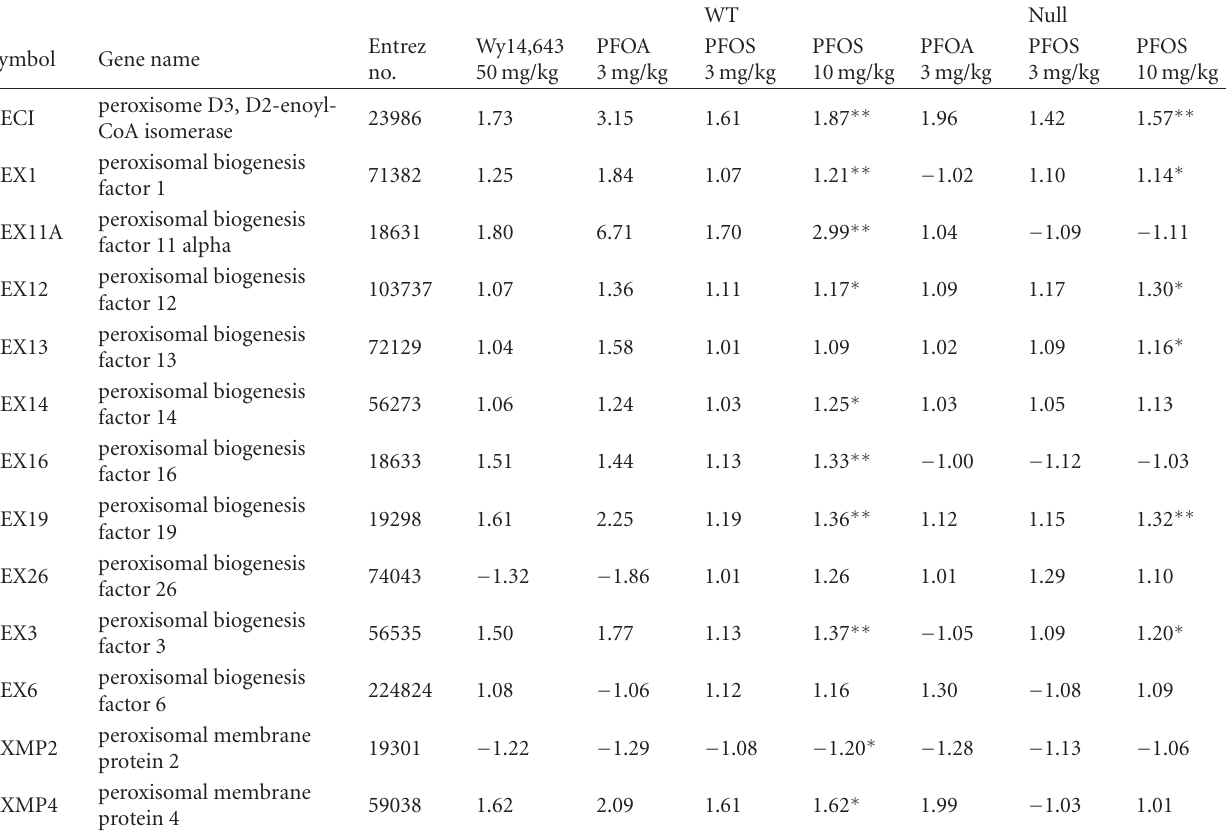
Table 5: Average fold change for genes related to peroxisome biogenesis in wild-type and PPAR α -null male mice following a seven-day exposure to Wy-14,643 1 , PFOA 1 , or